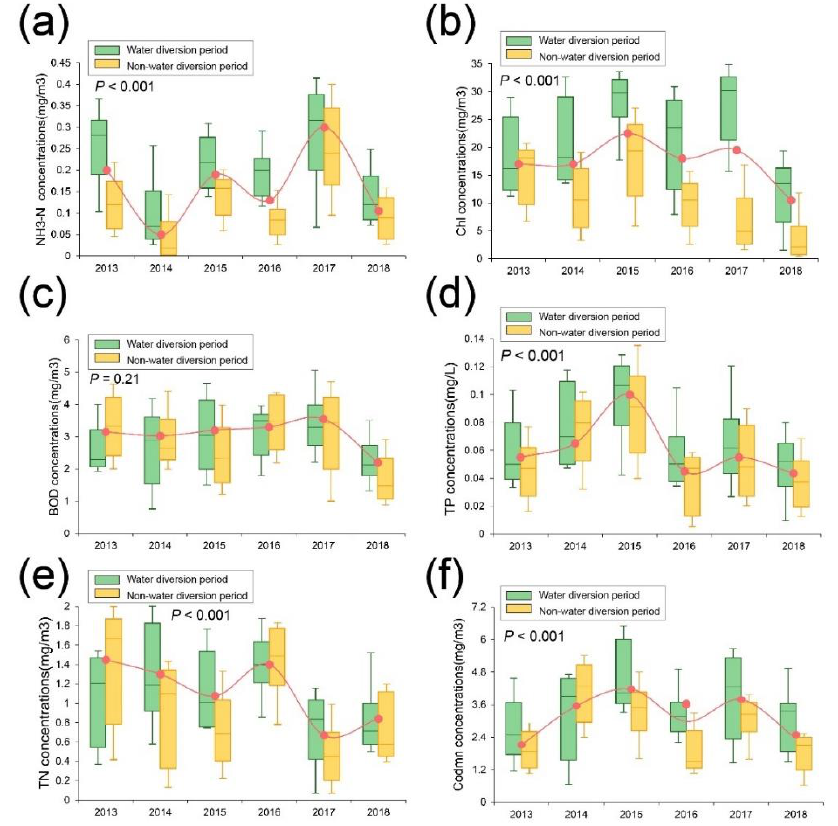
Figure 7. Temporal variations for Dongping Lake from 2013 to 2018 of ( a ) NH3-N in mg/L, ( b ) Chl in mg/m 3 , ( c ) BOD in mg/L, ( d ) TP in mg/L, ( e ) TN in mg/L and ( f ) CODMn in mg/L. The green bars represent water quality in the diversion seasons while the yellow ones in nondiversion seasons. The red lines represent the average concentration of water quality components for each year.